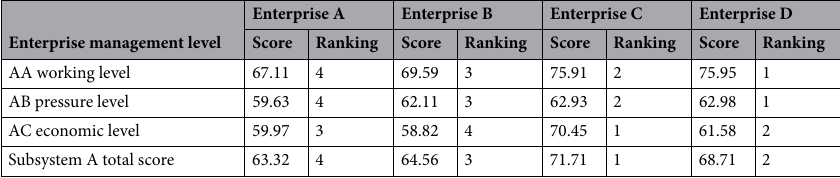
Table 7. Score ranking of safety management work (subsystem A) of four enterprises.